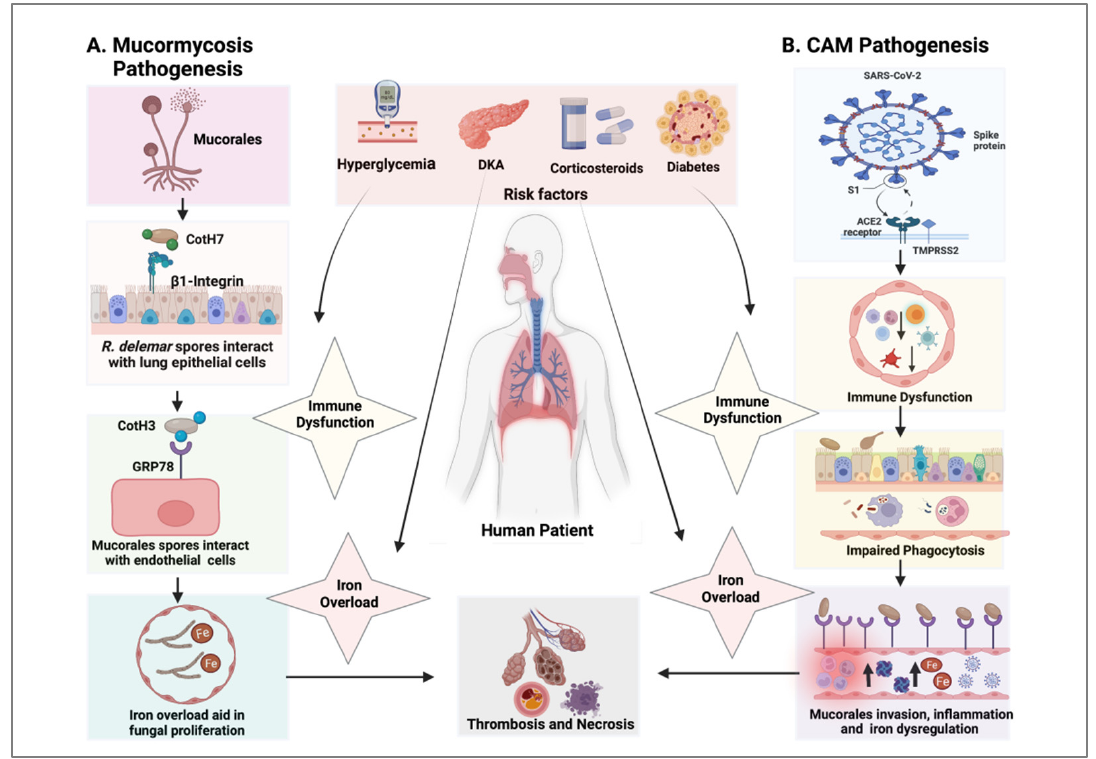
Figure 1. Panel A. Mucormycosis pathogenesis (in the absence of COVID-19): Mucorales sporulation produces spores that are inhaled through the respiratory system. Fungal spores interact with the lung epithelial surface through the CotH7 protein, which binds to the β -1 integrin receptor. This receptor–ligand interaction leads to epithelial cell invasion and damage. Mucorales also interacts with the glucose-regulated 78 kDa protein (GRP78) present on the surface of lung endothelial cells through its spore coat protein (CotH3), which results in cell invasion and tissue damage. Major risk factors are diabetes mellitus (DM), corticosteroid therapy, hyperglycemia, and diabetic ketoacidosis (DKA). Hyperglycemia leads to immune dysfunction, which is characterized by impaired activity of phagocytes, including functional chemotaxis/oxidative and non-oxidative killing mechanisms. Impaired fungal phagocytosis contributes to increased Mucorales endocytosis. DKA causes the iron overload in blood serum that contributes to Mucorales growth and proliferation, which ultimately results in blood vessel thrombosis via the occlusion of blood supply, cell damage, and tissue necrosis. Panel B. CAM pathogenesis (in the presence of COVID-19): The interaction of COVID-19 spike protein with host angiotensin-converting enzyme 2 (ACE2) and cell surface serine protease TMPRSS2 leads to downstream pathways, which results in virus entry and proliferation. Severe COVID-19 infection leads to immune dysfunction via the downregulation of B cells, T cells (lymphopenia), NK cells, neutrophils (neutrophil dysfunction), macrophages, and platelets (thrombocytopenia). COVID-19- mediated immune dysfunction can cause impaired phagocytosis of Mucorales spores, which results in Mucorales immune evasion. Mucorales spores find their way to the basement membrane where it adheres with laminin and collagen IV proteins of the extracellular matrix. Mucorales then interacts with endothelial cells through CotH3 protein via the GRP78 receptor, leading to Mucorales invasion. SARS-CoV-2 infection enhances GRP78 expression and also dysregulates iron homeostasis, thereby increasing the plasma concentration of free iron. Free iron is utilized by Mucorales for growth and proliferation, enhancing the extent of Mucorales invasion, cell damage, thrombosis, and tissue necrosis. Major risk factors include DM, corticosteroid therapy, DKA, and hyperglycemia. Created with